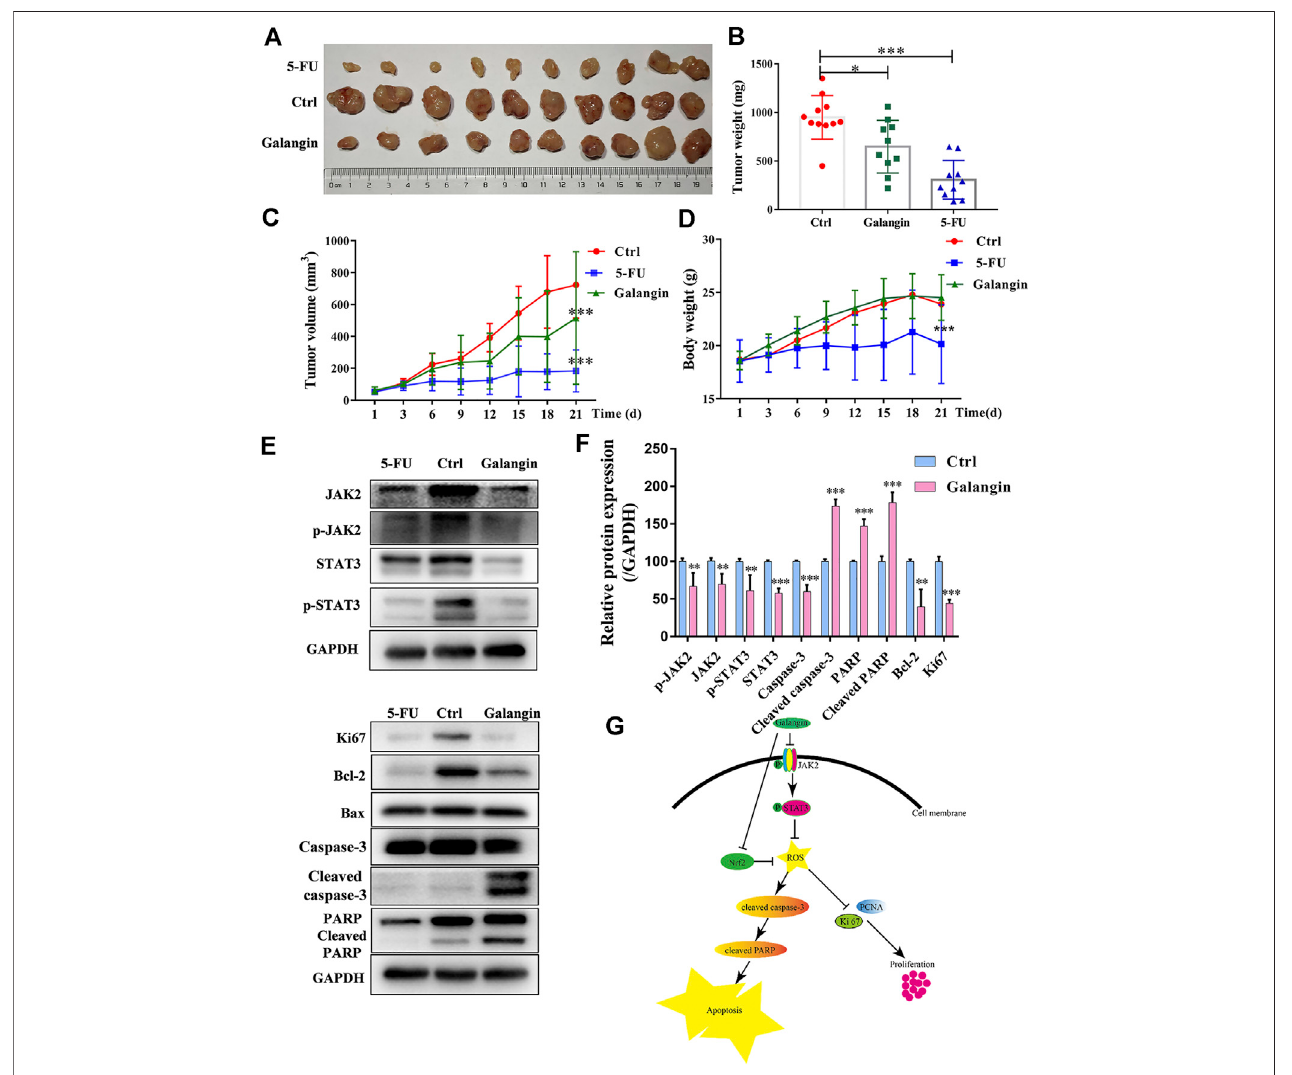
FIGURE 9 | Galangin inhibits tumor growth in the MGC 803 cell xenograft model. (A – B) Galangin (120 mg/kg) signi fi cantly inhibited tumor growth ( n (cid:2) 10). (C) Galangin (120 mg/kg) signi fi cantly inhibited tumor volume ( n (cid:2) 10). (D) Body weight changes (n (cid:2) 10). (E-F) Galangin modulated protein expression of JAK2, p-JAK2, STAT3, p-STAT3, Bcl-2, Caspase-3, Cleaved caspase-3, PARP, Cleaved PARP, and Ki67 in tumor tissues ( n (cid:2) 6). (G) Schematic illustration of possible underlying molecular mechanism of the inhibitory effect of galangin on MGC 803 cells. All of the data were shown as mean ± SD, and differences among ≥ 3 groups ( Figures 9B – F ) were analyzed by one-way ANOVA with Dunnett test by using GraphPad 7.0 software; * p < 0.05, ** p < 0.01; *** p < 0.001, compared with control